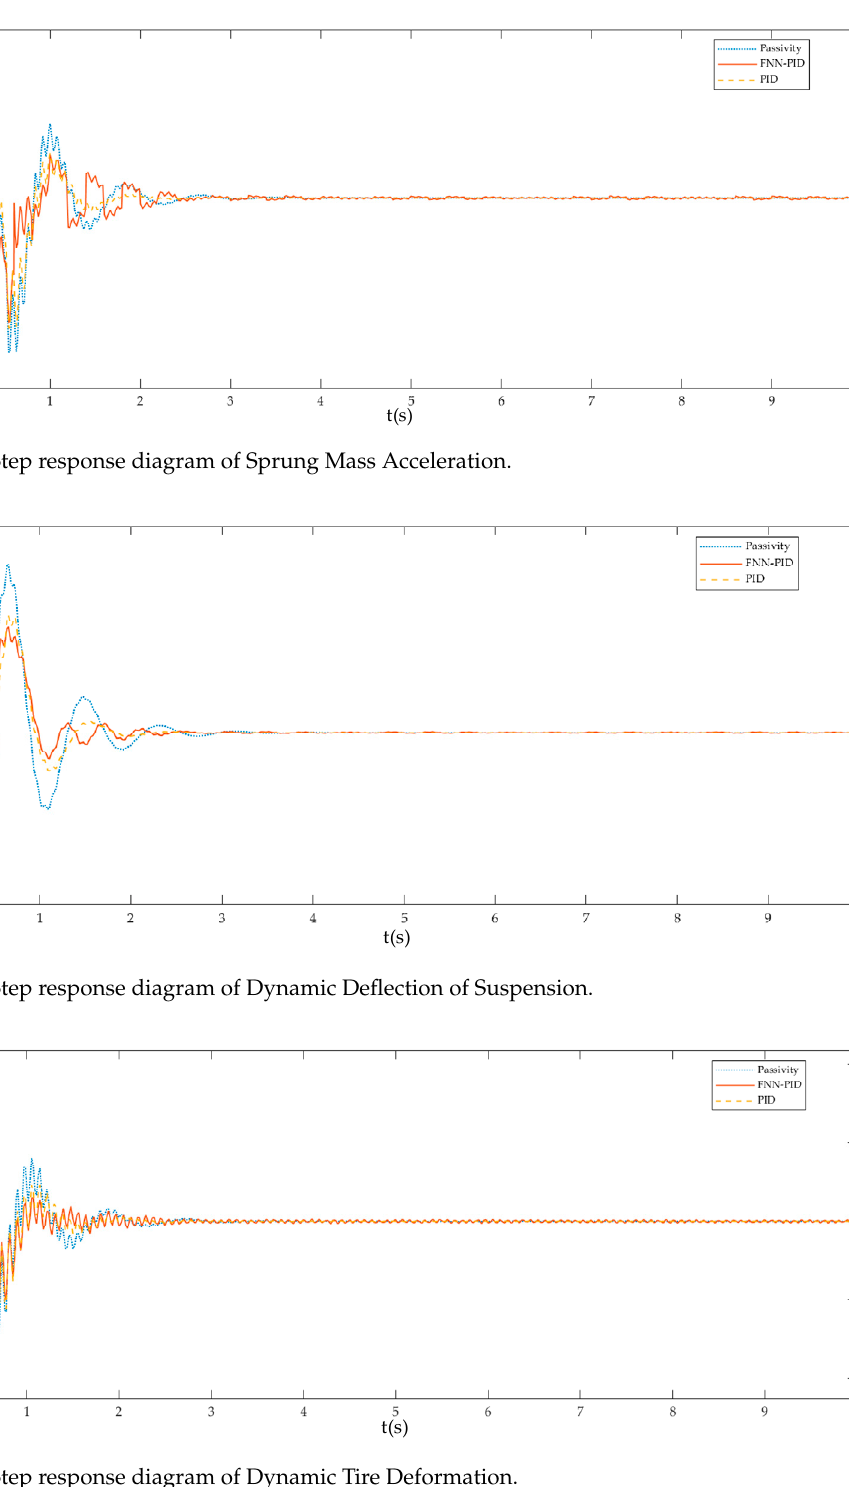
Figure 7. Step response diagram of Dynamic Tire Deformation.